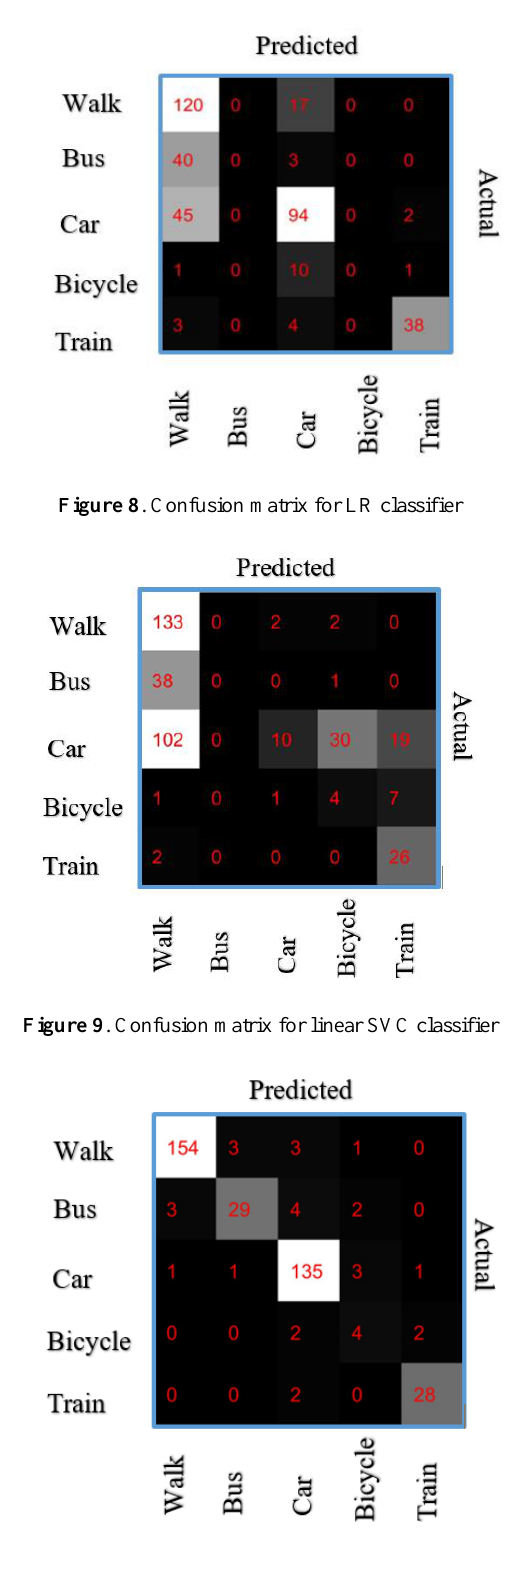
Figure 10 . Confusion matrix for GB classifier